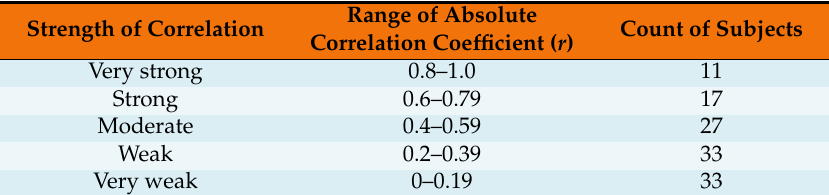
Table 4. Summary of Pearson correlation coefficient ( r ) strengths. Note: This statistics table is calculated based on the PAT RS* value, which scored the highest overall correlation with systolic blood